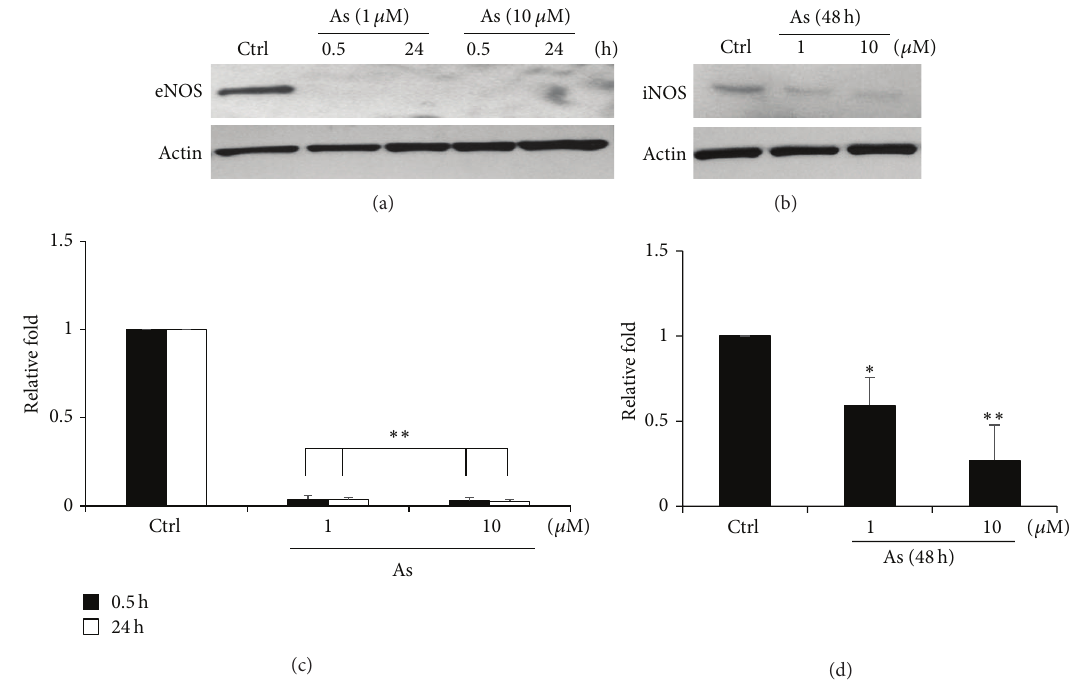
Figure 2: Arsenic attenuates the expressions of eNOS and iNOS. (a) Cells treated with 1 or 10 𝜇 M of arsenic for 0.5, 24 were used to monitor eNOS variations. (b) For investigating iNOS level, the cells were incubated with same concentration of arsenic for 48 hours. (c, d) The expression levels of eNOS and iNOS were statistically calculated from three repeats. Relative folds of protein levels shown as means ± S.E. compared to control. Statistical significance ( ∗ 𝑃 < 0.05 , ∗∗ 𝑃 < 0.01 ) analyzed using Fisher’s LSD.